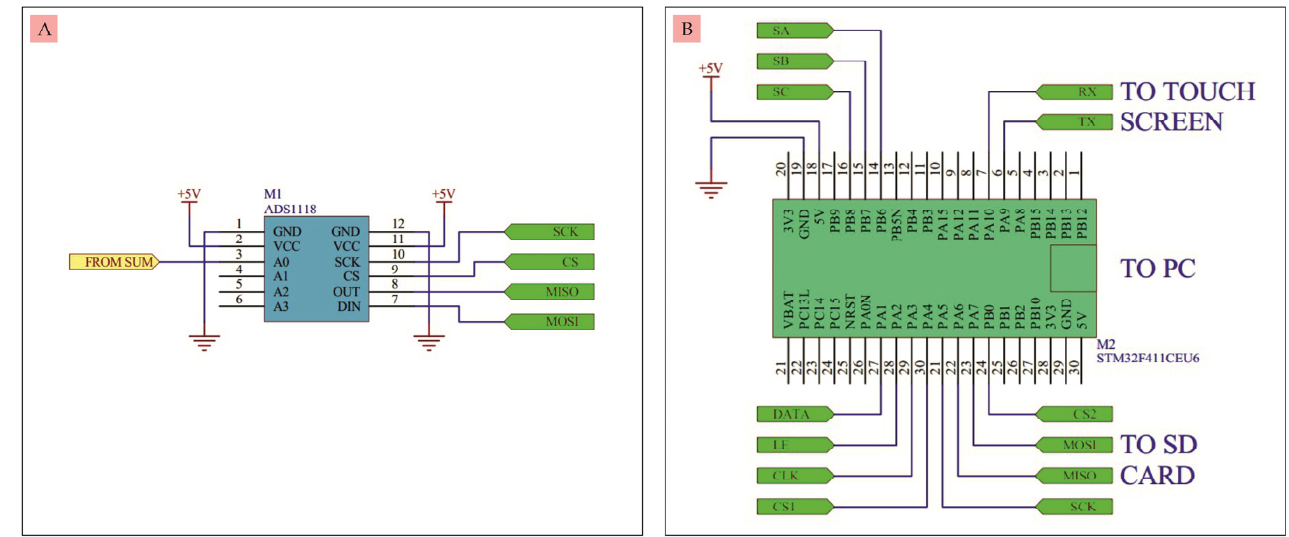
Figure 4. ( A ) 16-bit ADC circuit, ( B ) Microcontroller.